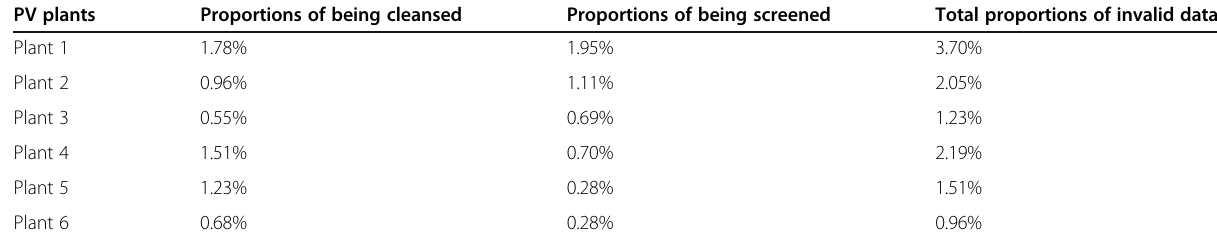
Table 2 Data preprocessing results PV